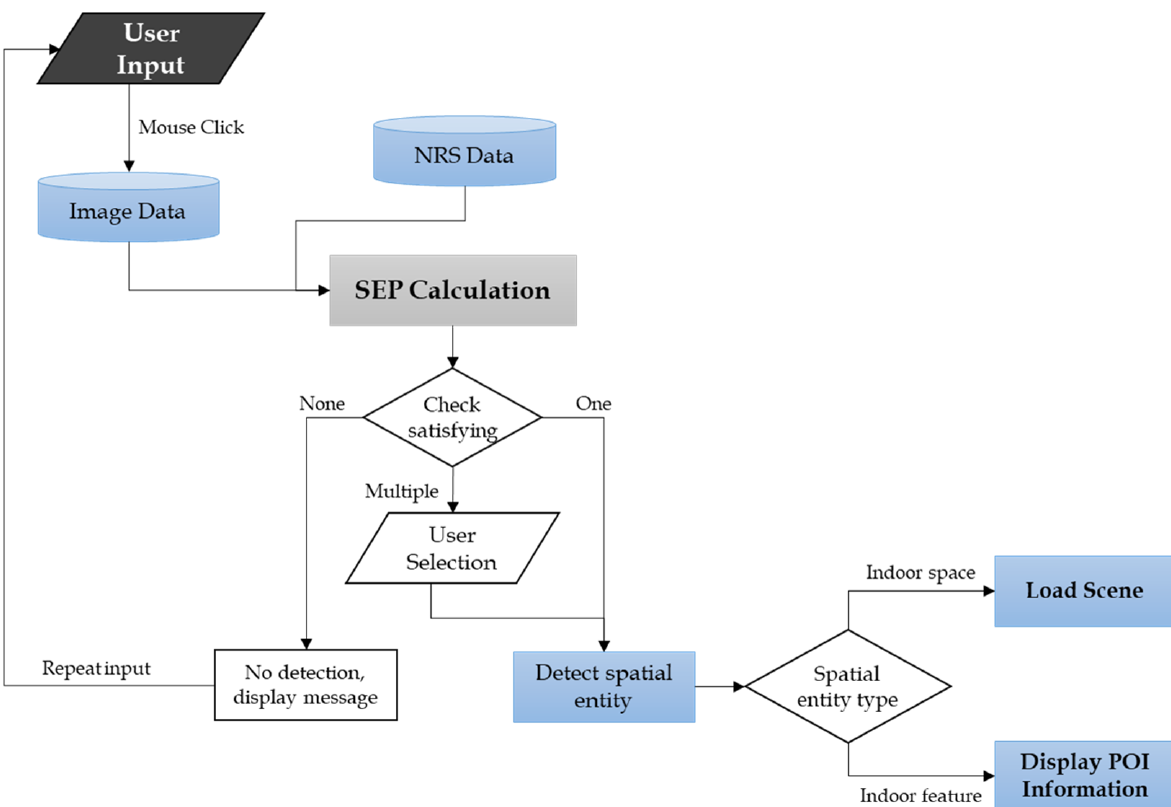
Figure 10. Relaying information on detected spaces and features on the images.